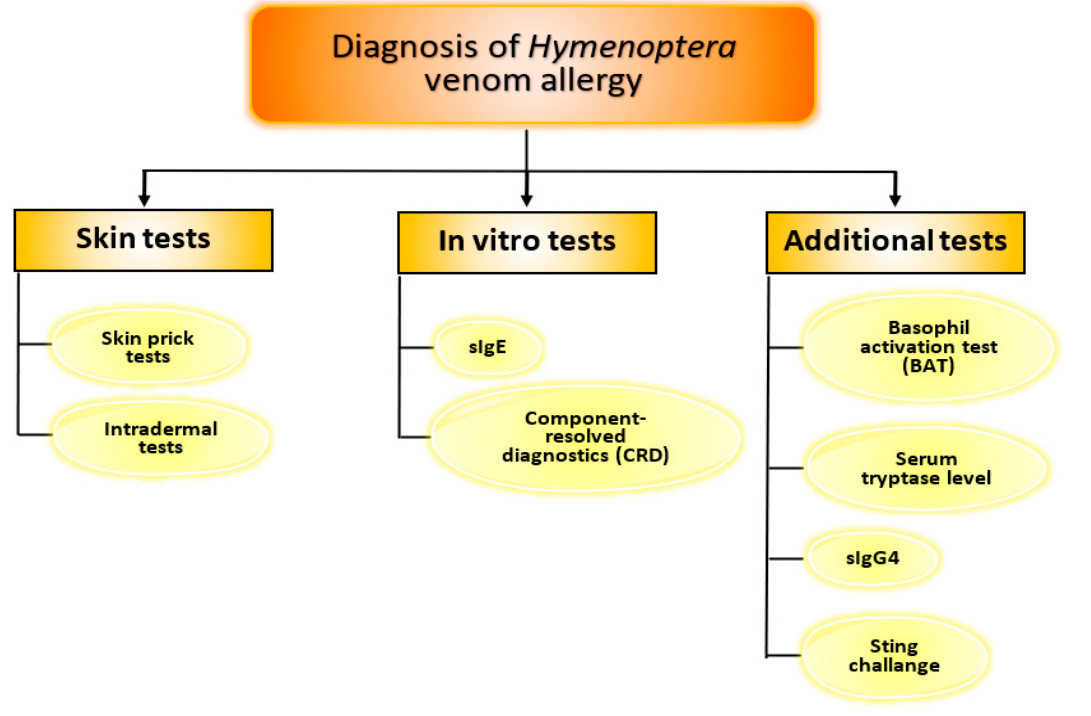
Figure 4. Diagnostic tools in Hymenoptera venom allergy.